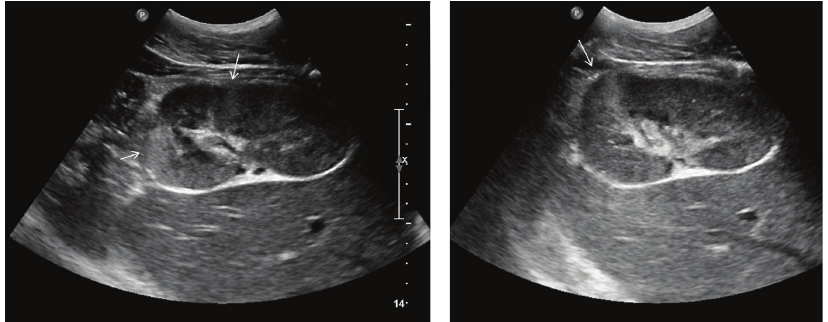
Figure 1: Findings: grey scale ultrasound image of right kidney showing ill-defined echogenic areas at lower pole of right kidney.